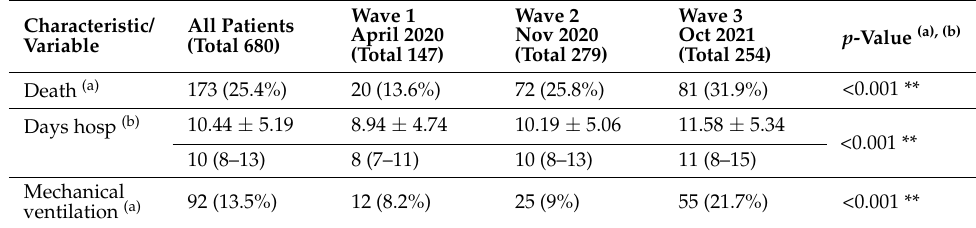
Table 2. Study outcomes across the three pandemic waves: descriptive statistics.